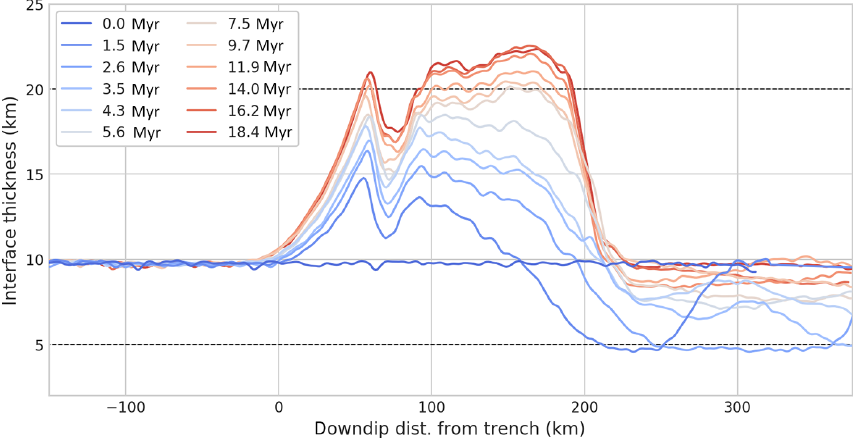
Figure 4. Interface thickness evolution in WL implementation. The initial layer thickness ( W init ) is 10km. Coloured lines show the evolving thickness plotted as a function of downdip distance from the trench. Dashed black lines show the expected maximum (equilibrium) and minimum (transient) thickness, based on a kinematic description of the flow evolving from a uniform thickness weak layer.